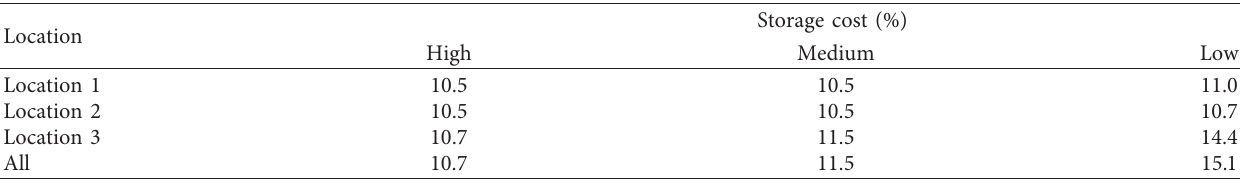
Figure 6: Optimal warehouse locations proposed by the k -means algorithm. (a) Freight cost decreases by increasing the number of optimized warehouses. Orange and green lines show the actual freight cost and the freight cost of transfers from the current nearest company warehouses. (b) Distribution of customers based on their distance from the nearest warehouse. (c) A network of customers (blue circles) and current (orange triangles) and optimized (red triangles) warehouse locations. Yellow circles denote geographical areas where candidate warehouses should be placed but that currently have inactive warehouses (Locations 1 and 2) or no warehouse (Location 3). Table 1: Potential cost savings if additional warehouses are